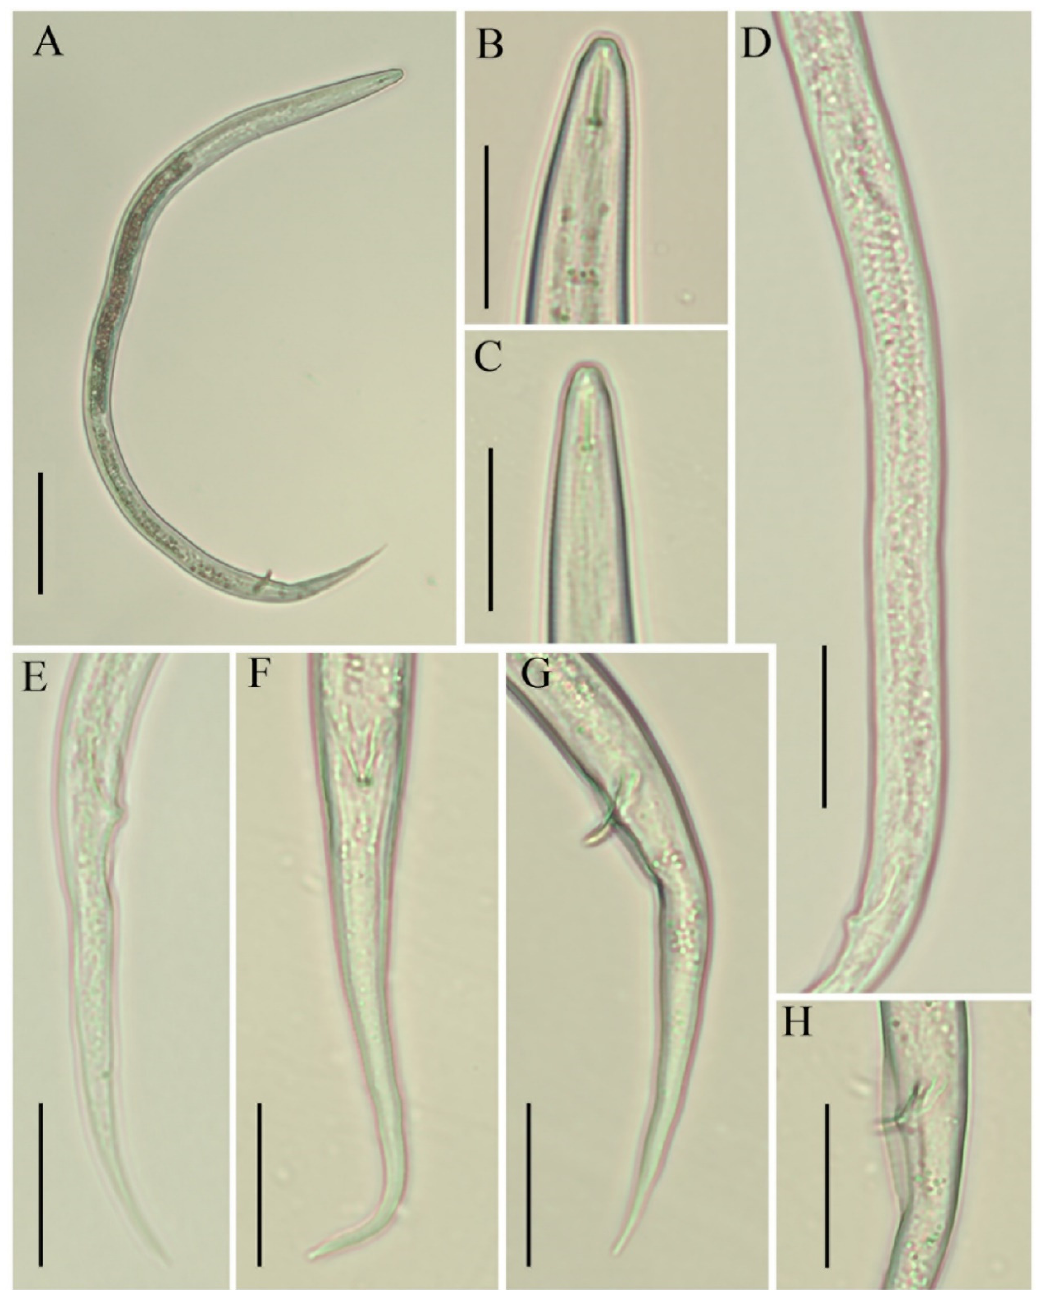
Figure 2. Photomicrographs of Boleodorus thylactus male, Canadian population 61. ( A ) Entire body; ( B , C ) lip region; ( D ) gonad; ( E – G ) tails; ( H ) cloacal region with bursa. Scale bars: ( A ) 50 µm; ( B – H ) 20 µm.